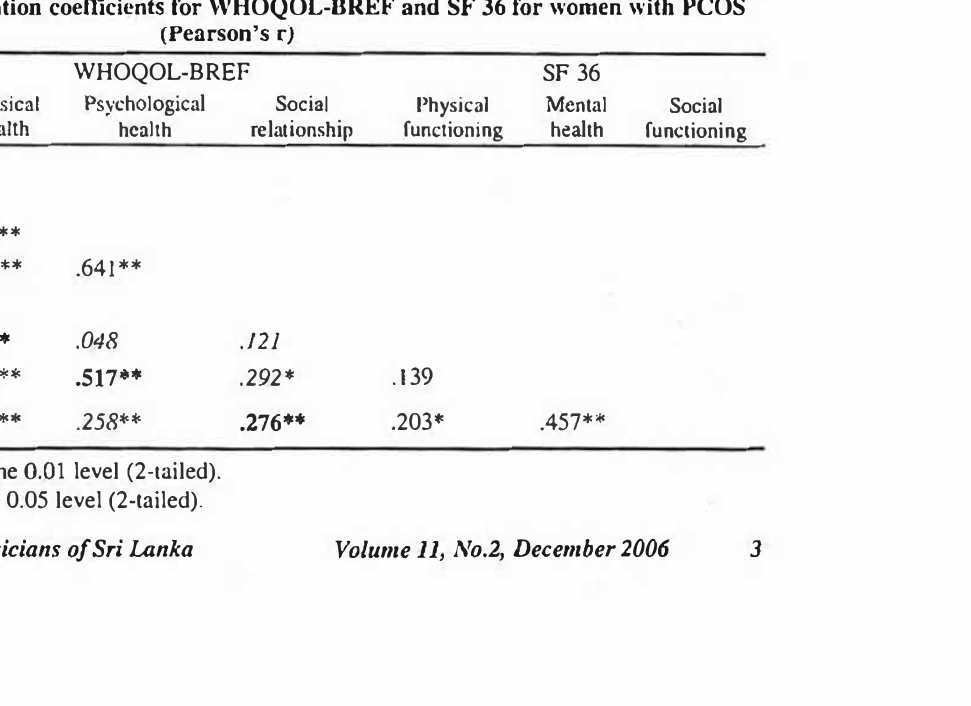
Table 1 -MTMM of correlation coefficients for WHOQOL-BREF and SF 36 for women with